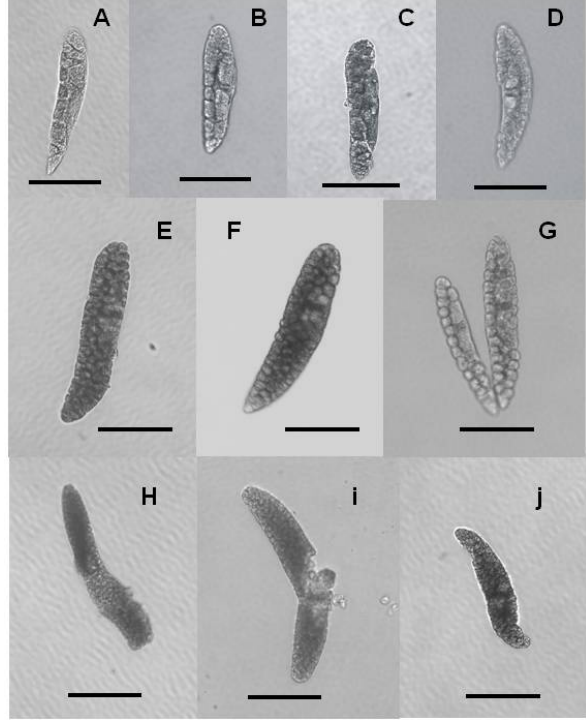
Fig. 3. Different morphotypes of Blastodinium spp. with a spindle shape. (A) : BOUM5, (B) : BOUM27, (C) : BOUM21, (D) : BOUM29, (E) : BOUM3, (F) : BOUM35, (G) : BOUMPARE4 (see also Fig. S1), (H) : BOUM19 (see also Fig. 2), (I) : BOUM26, (J) : BOUM4. Scale